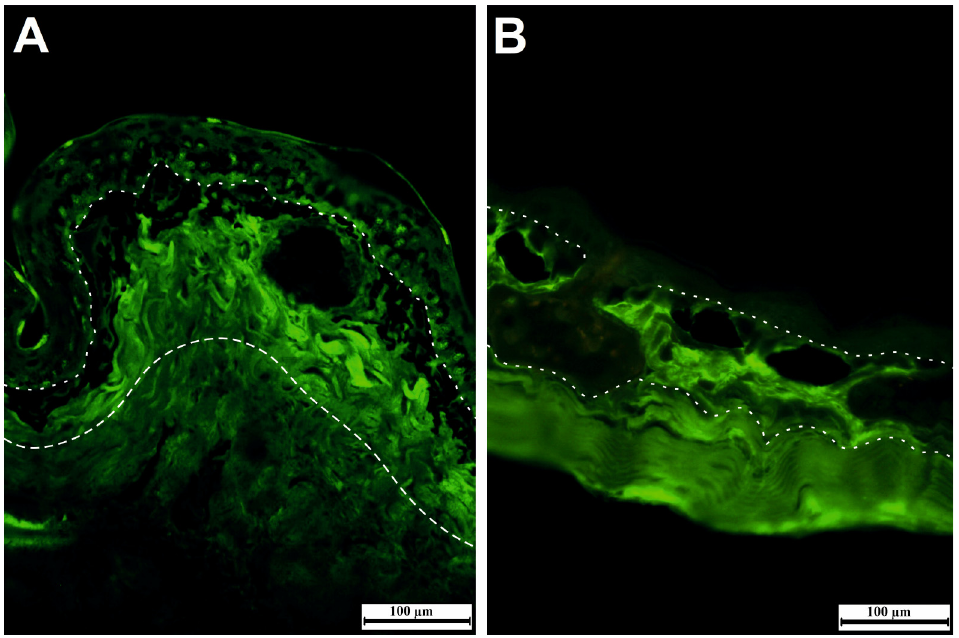
Figure 5. Immunoreactivity of hyaluronic acid (HA) in the dermis of Salamandra infraimmaculata ( A ) and Hyla savignyi ( B ), mainly in the upper region of the dermis.